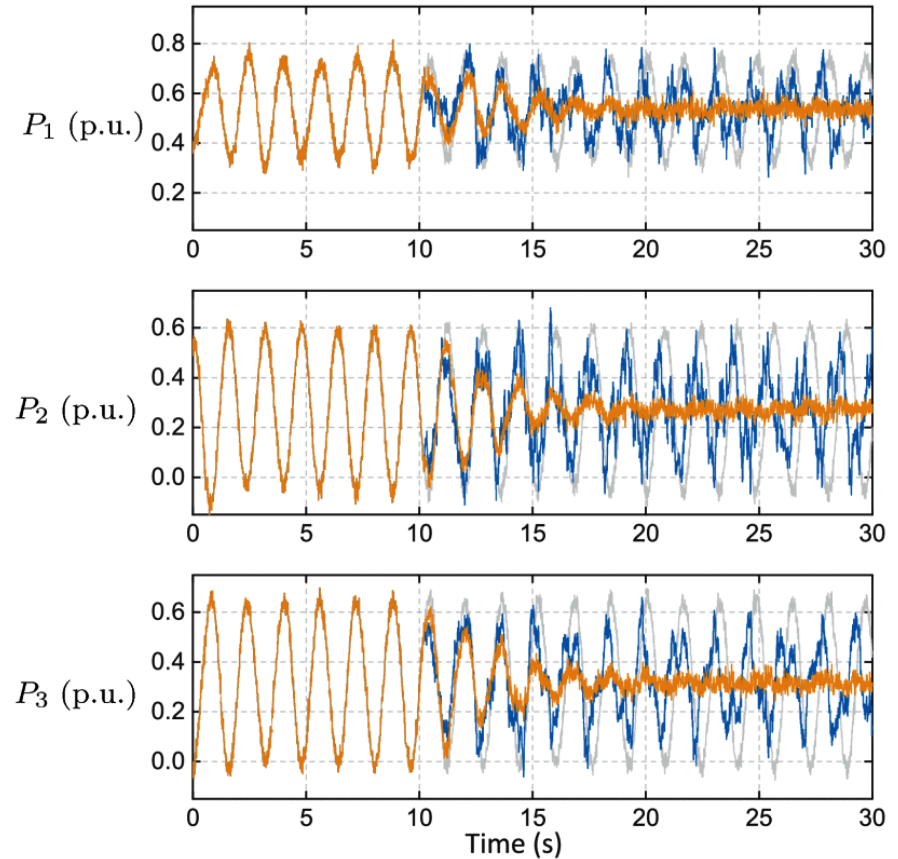
Figure 22. Comparison of data-driven predictive control and model-based predictive control. Grey color: without control. Blue color: model-based predictive control. Orange color: data-driven predictive control.